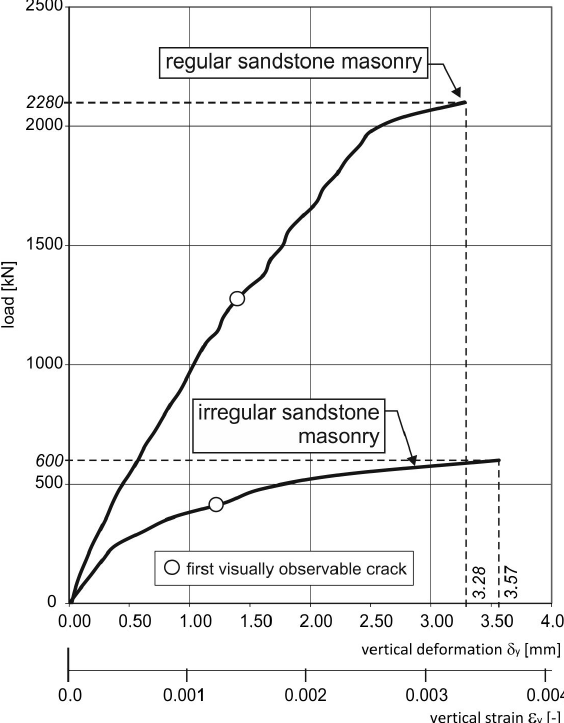
Fig. 2. Experimentally identified working diagrams of sandstone masonry of regular blocks and of quarry